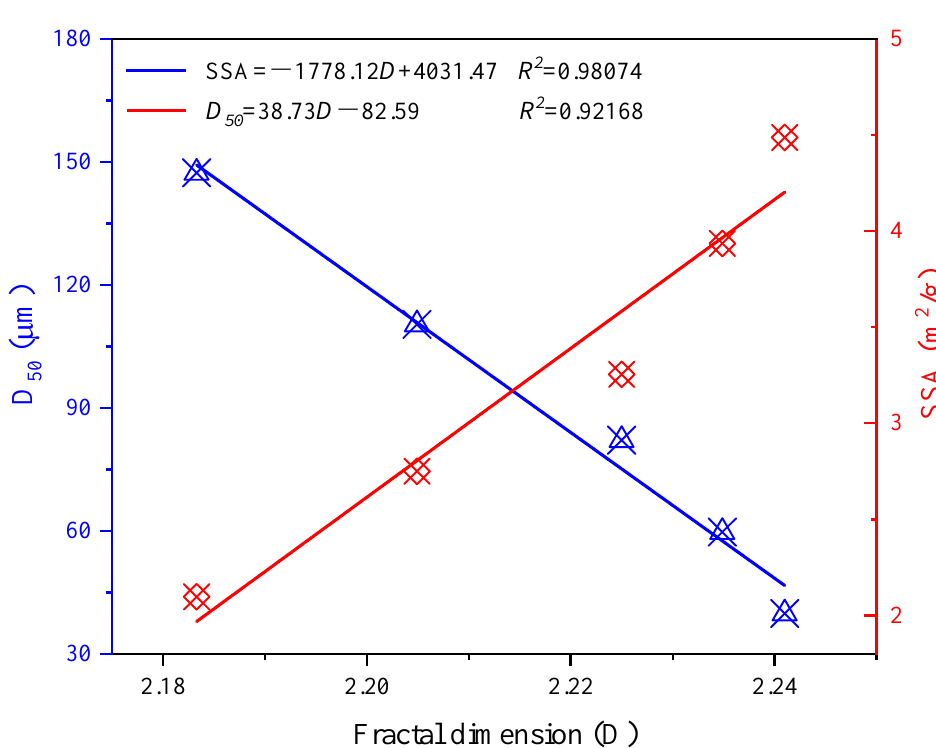
Figure 10. Relationship between fractal dimension and SSA, D 50 of CGS.